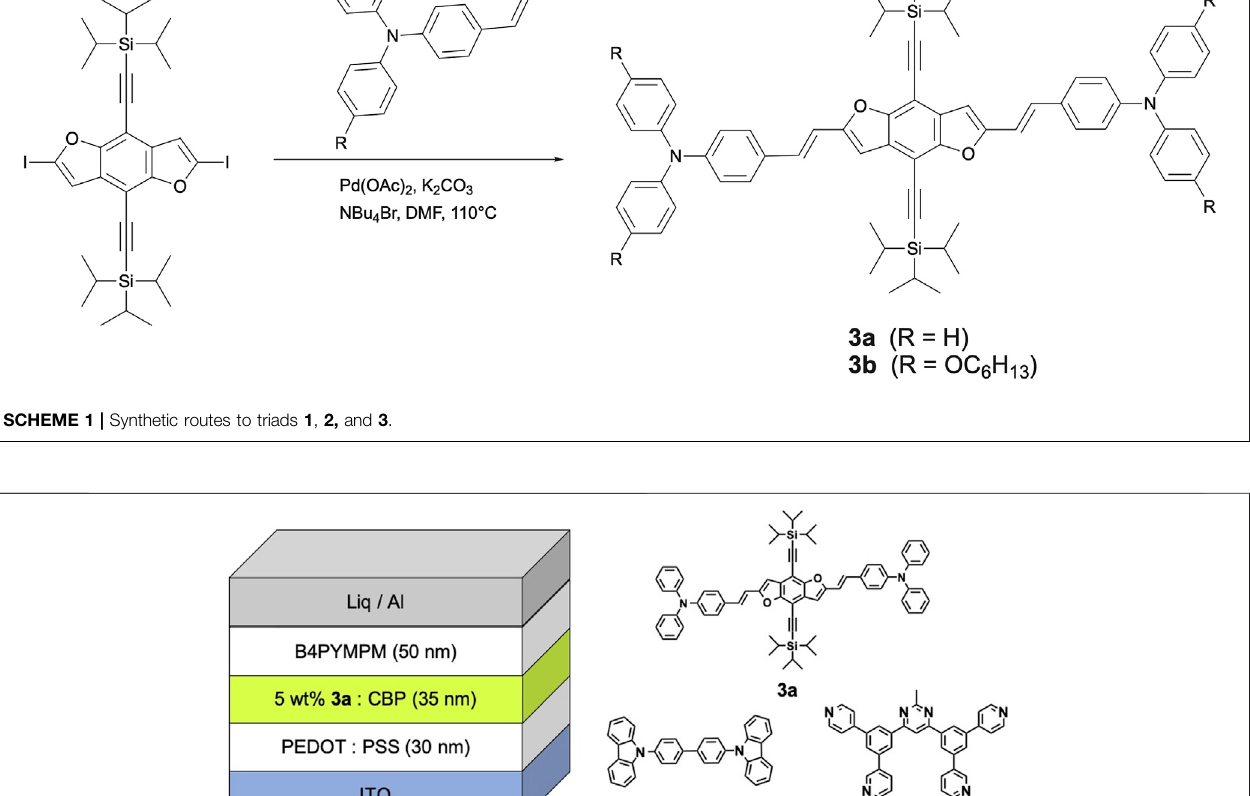
Frontiers in Chemistry |